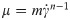
Shear-dependent blood viscosity.
A: Whole blood viscosity (μwb). B: Relative viscosity (μrel) to plasma viscosity (μpl) before and after dextran infusion at 35°C (n = 10). The solid lines represent curve fittings by the power-law model (μ=mγ˙n−1). (μwb, before: m = 18.87, n = 0.75, R
2 = 0.79; μwb, after: m = 43.88, n = 0.60, R
2 = 0.91; μrel, before: m = 15.67 n = 0.75, R
2 = 0.79; μrel, after: m = 28.86, n = 0.60, R
2 = 0.91) (* P < 0.001, ** P < 0.0001).